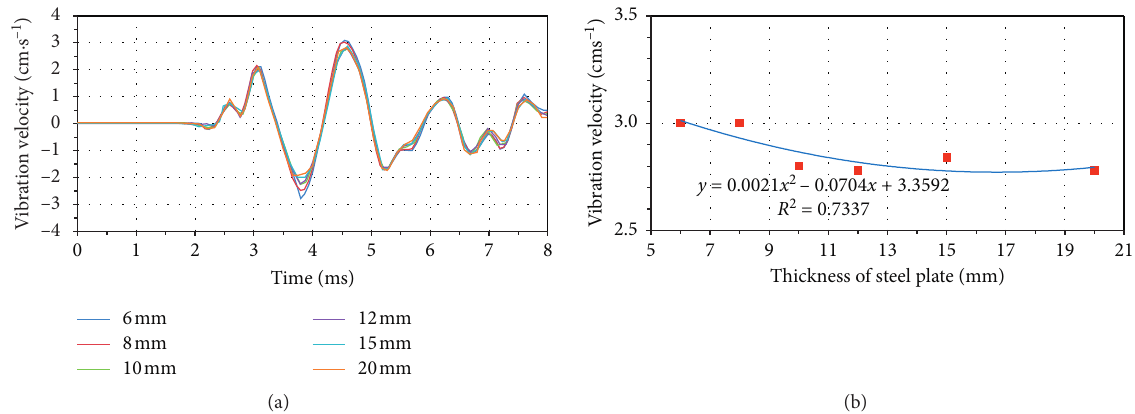
Figure 9: Vibration velocity curves corresponding to different steel plate thickness. (a) Vibration velocity curves with different steel plate thickness. (b) Vibration velocity fitting curve under different steel plate